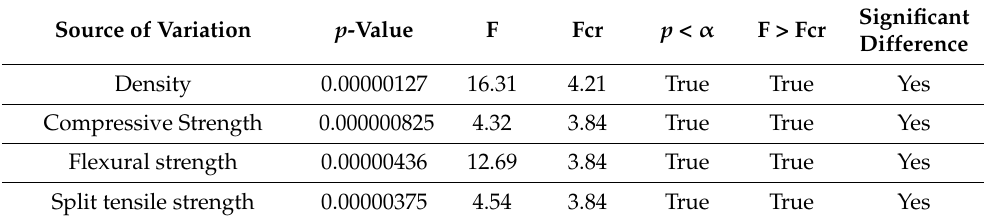
Table 5. Statistical analysis using Two-way analysis of variance